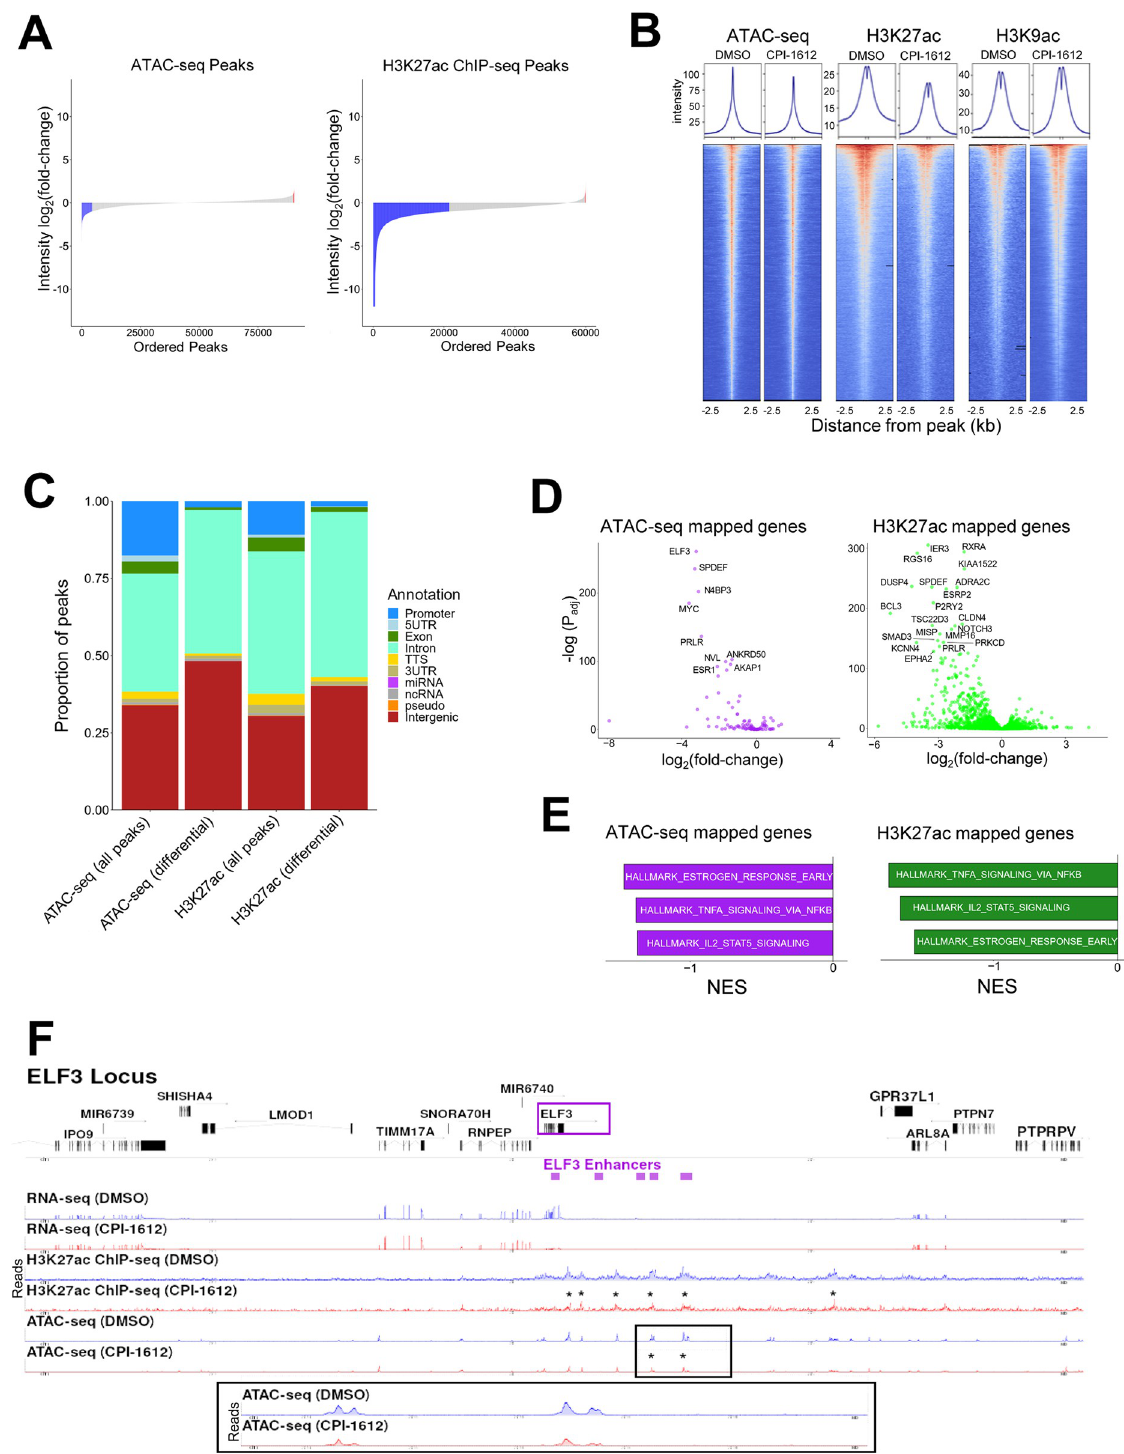
Fig 3. CPI-1612 represses a subset of enhancers which are linked to differentially expressed genes. (A) CPI-1612 treatment impacts chromatin accessibility and histone acetylation. MCF7 cells were treated for 6 hours with DMSO or CPI-1612 (50 nM), and samples were prepared for ATAC-seq or ChIP-seq with H3K27ac or H3K9ac antibodies. Waterfall plot of the log 2 (fold-change) in signal intensity in open chromatin (ATAC-seq) peaks and H3K27ac peaks between DMSO and 50 nM CPI-1612 treatment. Blue: peaks with at least 2-fold decrease in signal; red: peaks with at least 2-fold increase in signal. (B) Global effects of CPI-1612 treatment. Top 30,000 peaks for each feature were